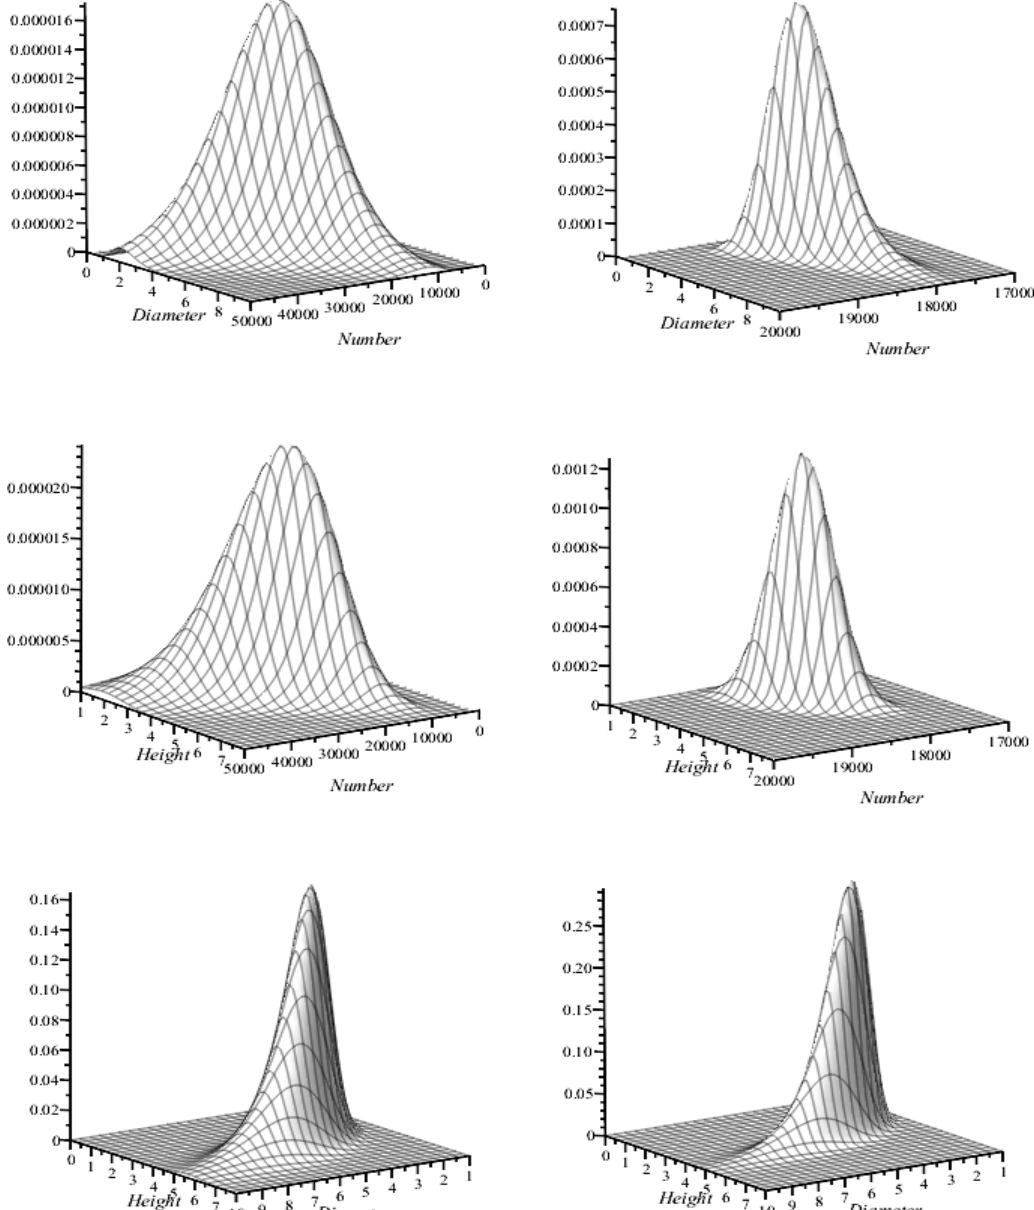
Figure 3. Stationary estimated marginal bivariate probability density functions (represents the same stand as in Figure 2) for both ( Left ) fixed- and ( Right ) mixed-effects scenarios. The average stand age was 88 years.